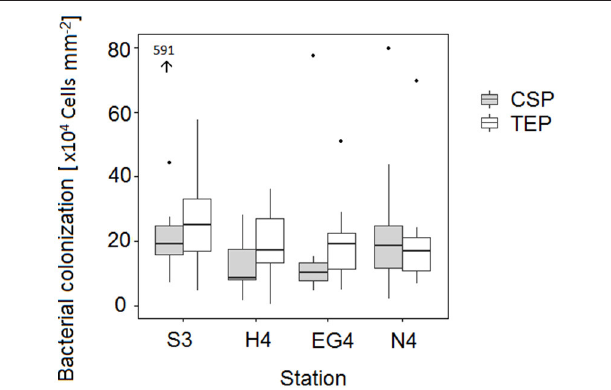
FIGURE 6 | Difference in bacterial colonization (mm − 2 ) between the two gel particle types (TEP and CSP), combined for all depths at the four stations. Values presented in the graph were calculated from total bacterial abundances (i.e., bacterial frequency sums per particle size classes in 1 L of seawater) and the total areas of gel particles (in 1L of seawater). Outliers are represented by dots and also by the black arrow (the number next to the arrow indicates the respective y